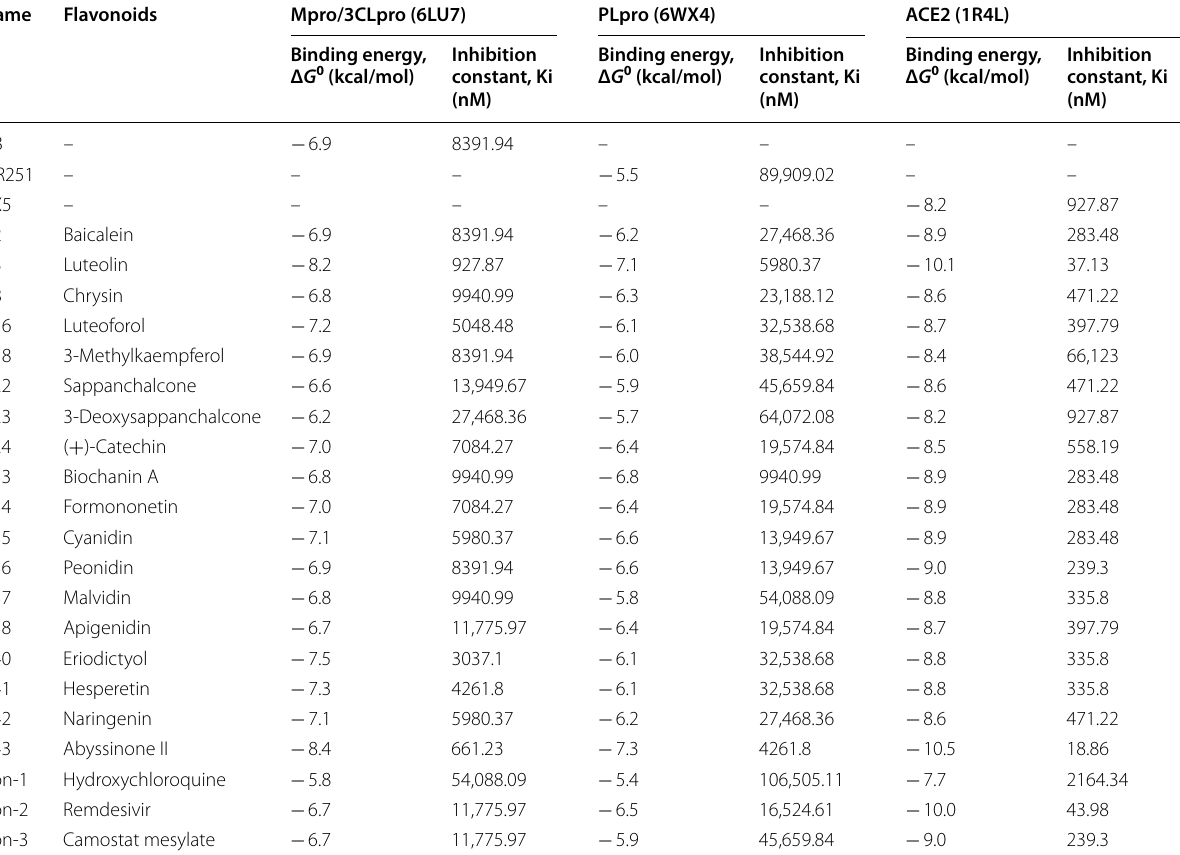
Table 4 Computed binding free/Gibbs free energy (Δ G 0 ) and calculated inhibition/dissociation constant (Ki) scores of reference ligands, selected flavonoids and drugs (used as control) against Mpro/3CLpro, PLpro and ACE2 of